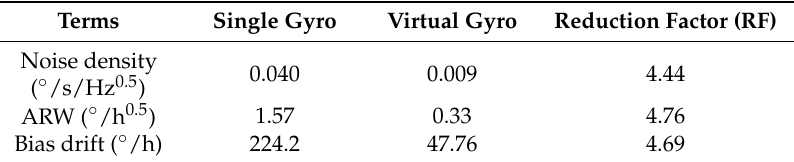
Figure 13. Allan variance results of combined angular rate signal compared to single gyroscope. Table 5. Drift test results of the four-gyro array.